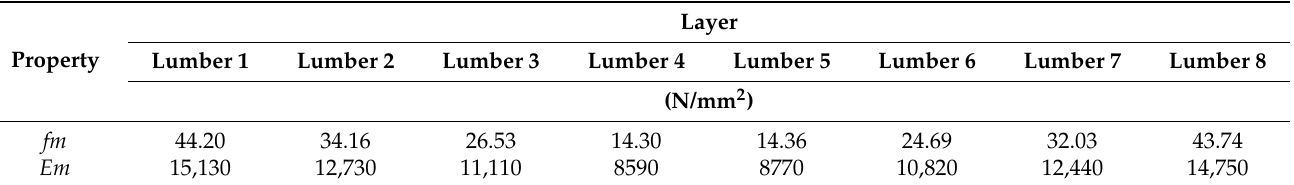
Table 2. Material properties for 8-layer beams.